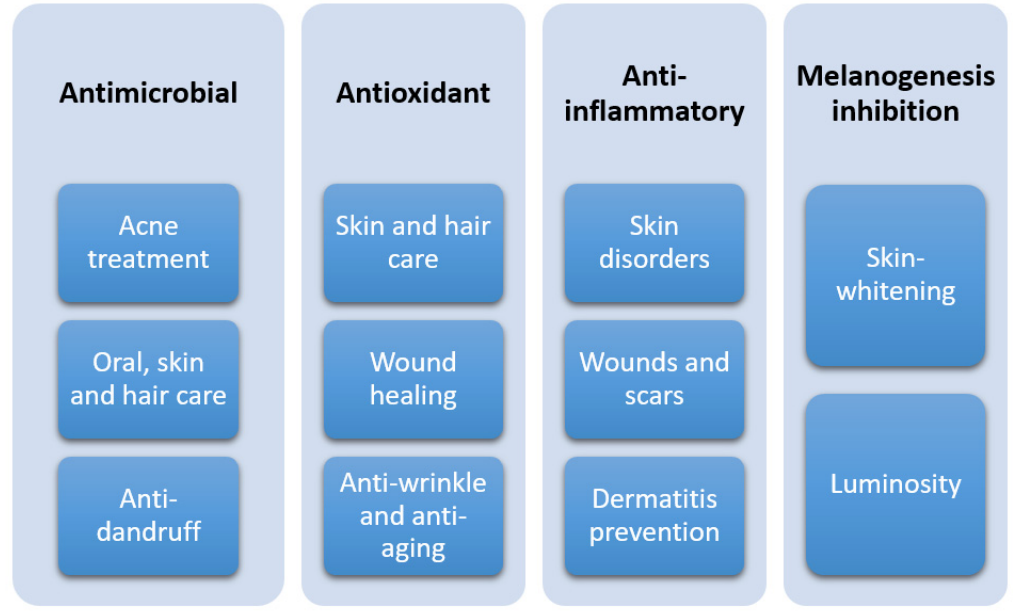
Figure 1. Main A. indica biological activities with their dermocosmetic attributes.